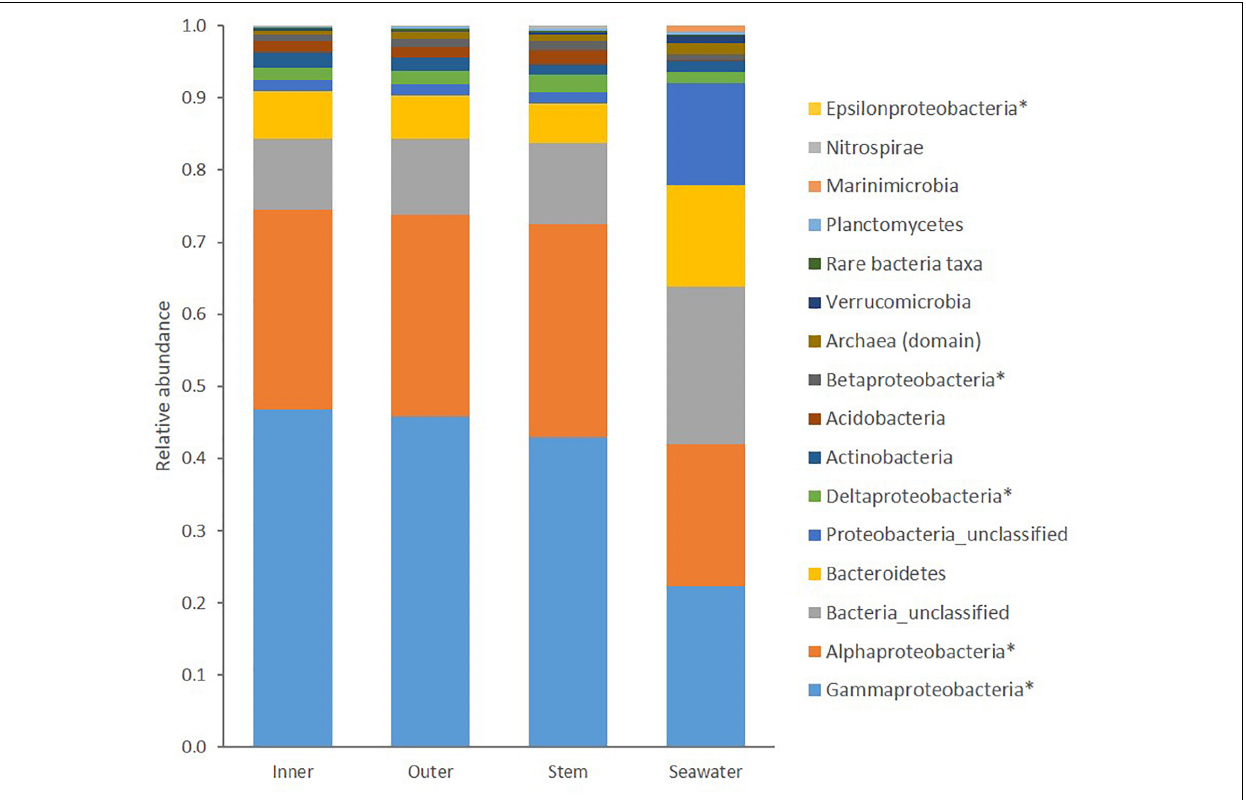
FIGURE 1 | Taxonomic composition of prokaryotic communities in the Inner cup, Outer cup, and Stem of Cliona patera and ambient seawater. Asterisks ( ∗ ) denote classes within the phylum Proteobacteria, and all representatives of the Domain Archaea have been grouped. TABLE 1 | Alpha diversity metrics for prokaryotic communities in Cliona patera and ambient seawater. Group Richness (S obs ) Richness (Chao) Evenness (Shannon) Diversity (inv.